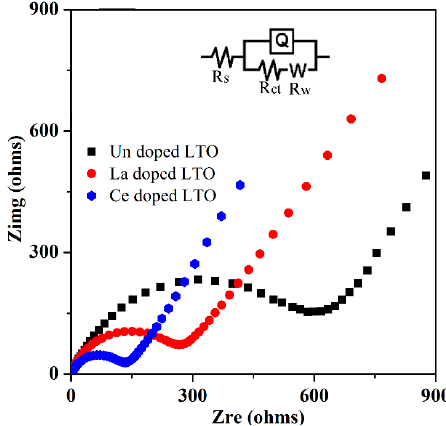
Figure 8. Electrochemical impedance spectra of Ce/La-doped LTO, undoped LTO and pure Li 4 Ti 5 O 12 electrodes (inset shows the equivalent circuit).